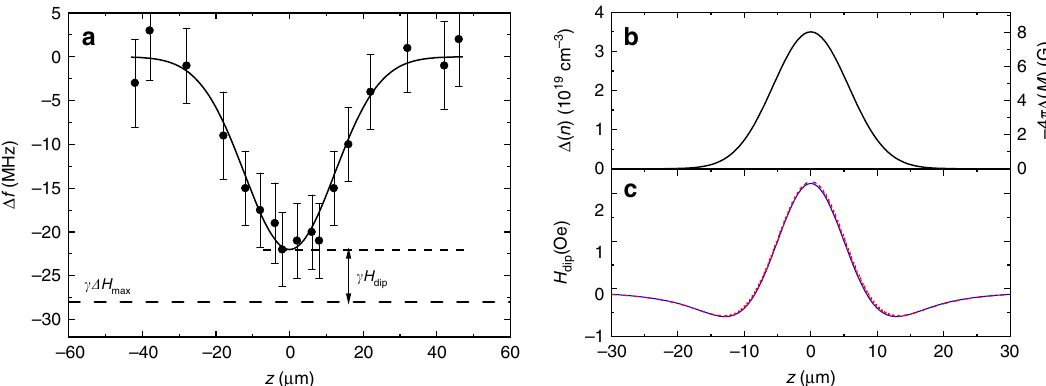
Fig. 4 Spatial distributions of the condensate frequency and of the induced dipolar fi eld. a Spatial pro fi le of the frequency shift of the condensate caused by the presence of the potential well ( Δ H max = − 10 Oe). Symbols — experimental data obtained using BLS with an ultimate frequency resolution. Solid curve — fi t of the experimental data by a Gaussian peak. Horizontal dashed line marks the expected maximum frequency shift, − 28 MHz caused by Δ H = − 10 Oe. Error bars are standard deviation. b Non-uniform distributio n Δ n ( z ) used for calculations of the dipolar fi eld H dipolar fi eld H dip calculated analytically (solid curve) and numerically (dashed